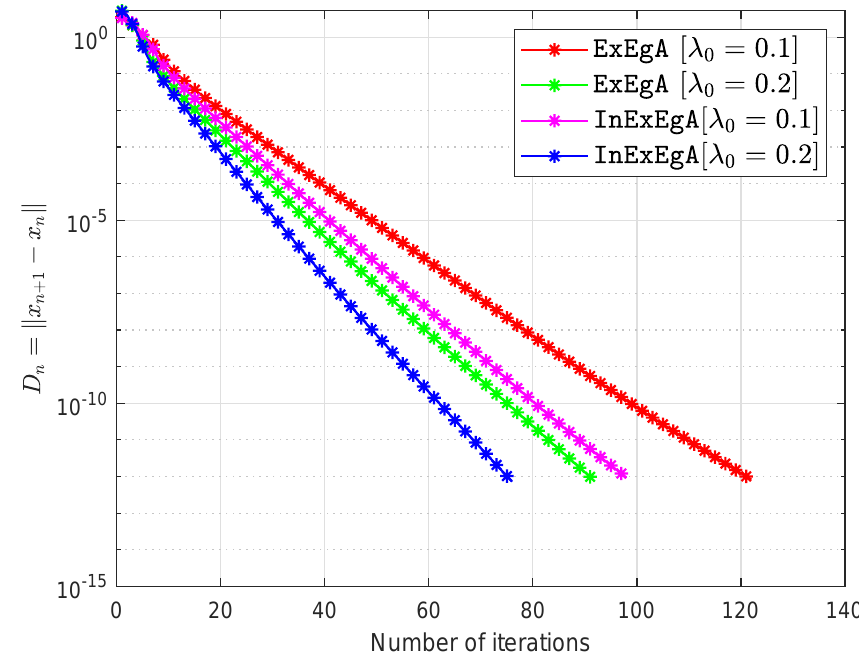
Figure 3. Algorithm 1 comparison with Algorithm 1 in [16] in term of iterations when n = 20.